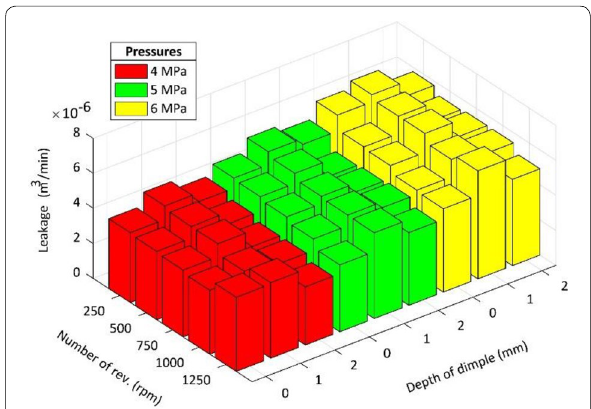
Figure 7 Leakage under different study parameters for different dimple depths